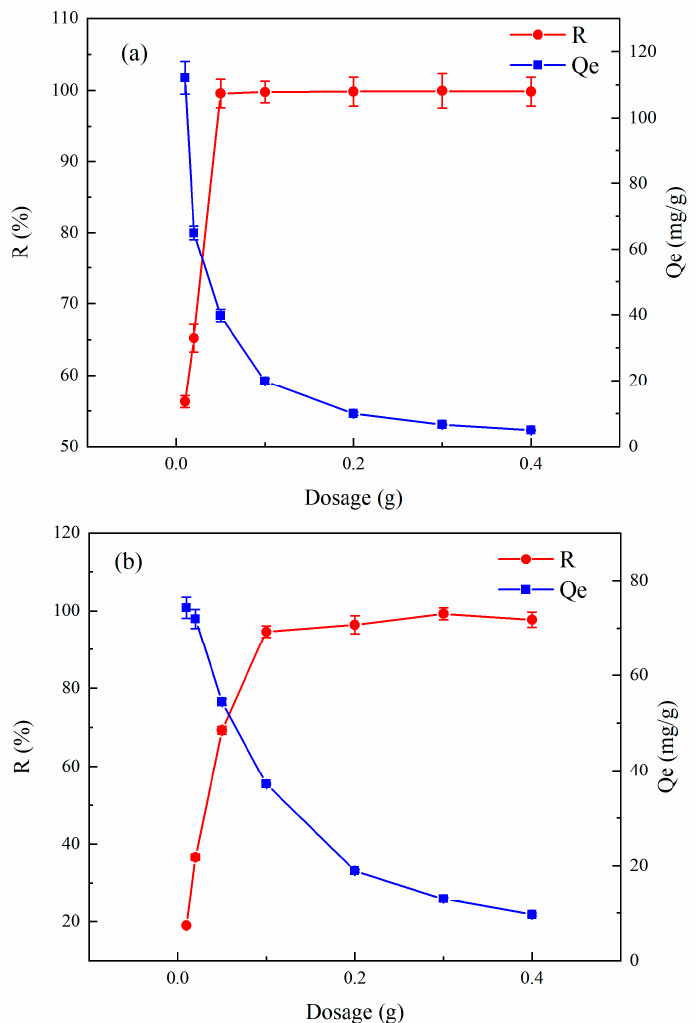
Figure 7. Removal efficiency of ( a ) MB and ( b ) OFL adsorbed by SAC versus adsorption amount with dosing.